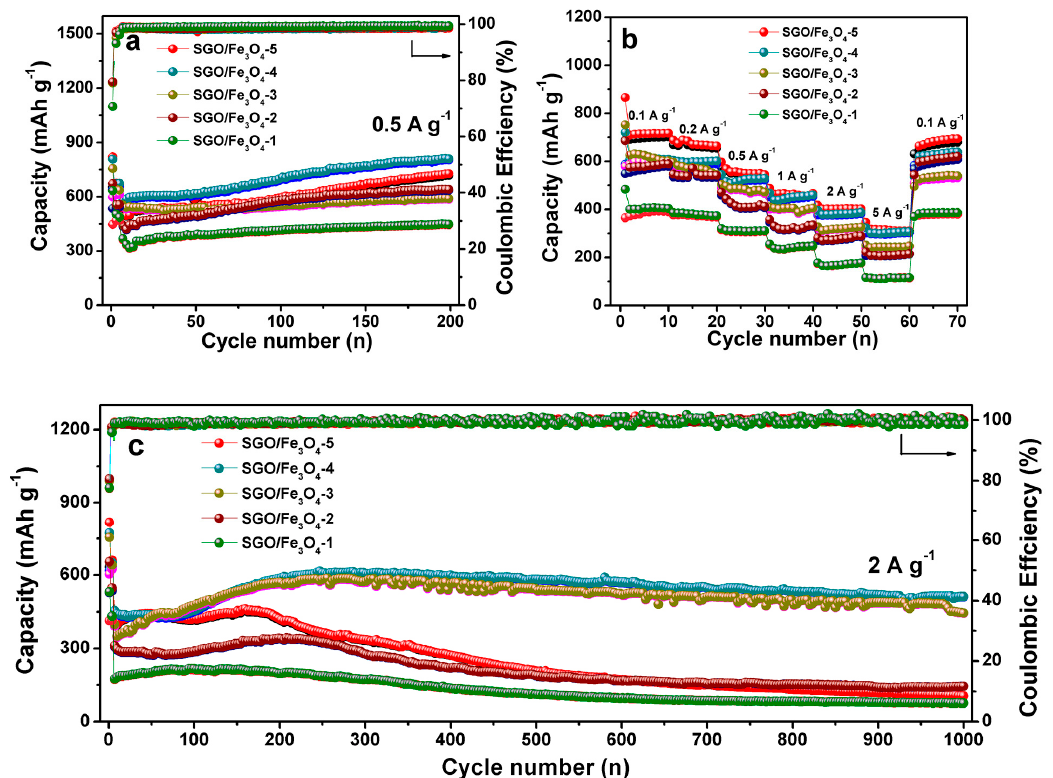
Figure 5. ( a ) Cycling performance at 0.5 A g − 1 for 200 cycles, ( b ) rate capability, and ( c ) long-periodic cycling performance of different composites at 2 A g − 1 for 1000 cycles.